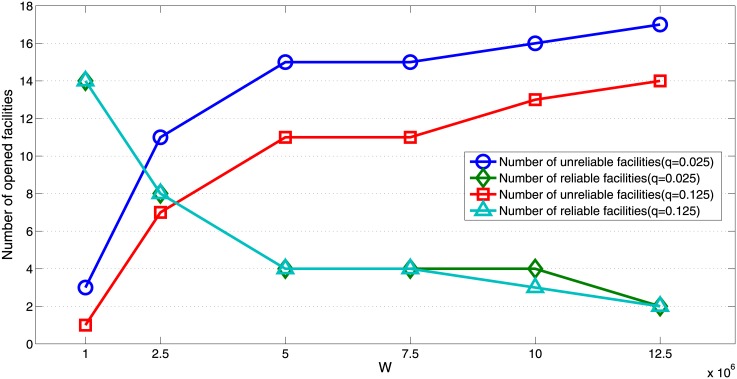
Number of sites with facilities opened corresponding to different W.